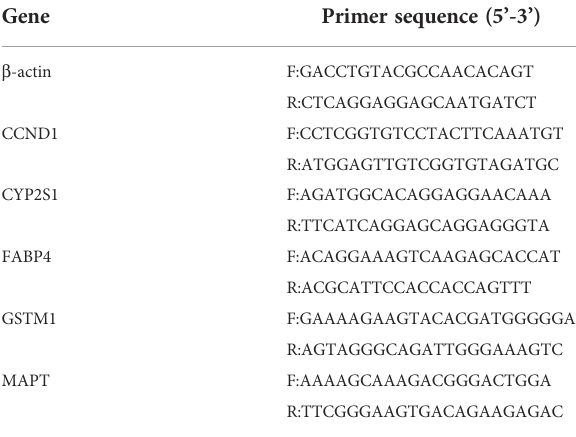
TABLE 1 Primer sequences of genes in the risk model used for qPCR. Primer sequence (5 ’ -3 ’ )